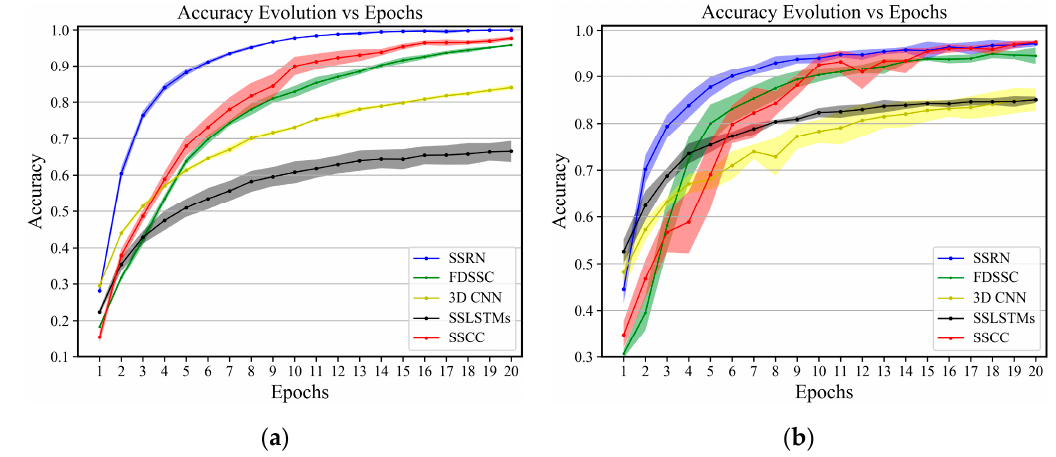
Figure 16. Indiana Pines: Evolution of the accuracy in terms of epochs on ( a ) training data and ( b ) validation data. The shadow shows the standard deviation of the accuracy for five executions.